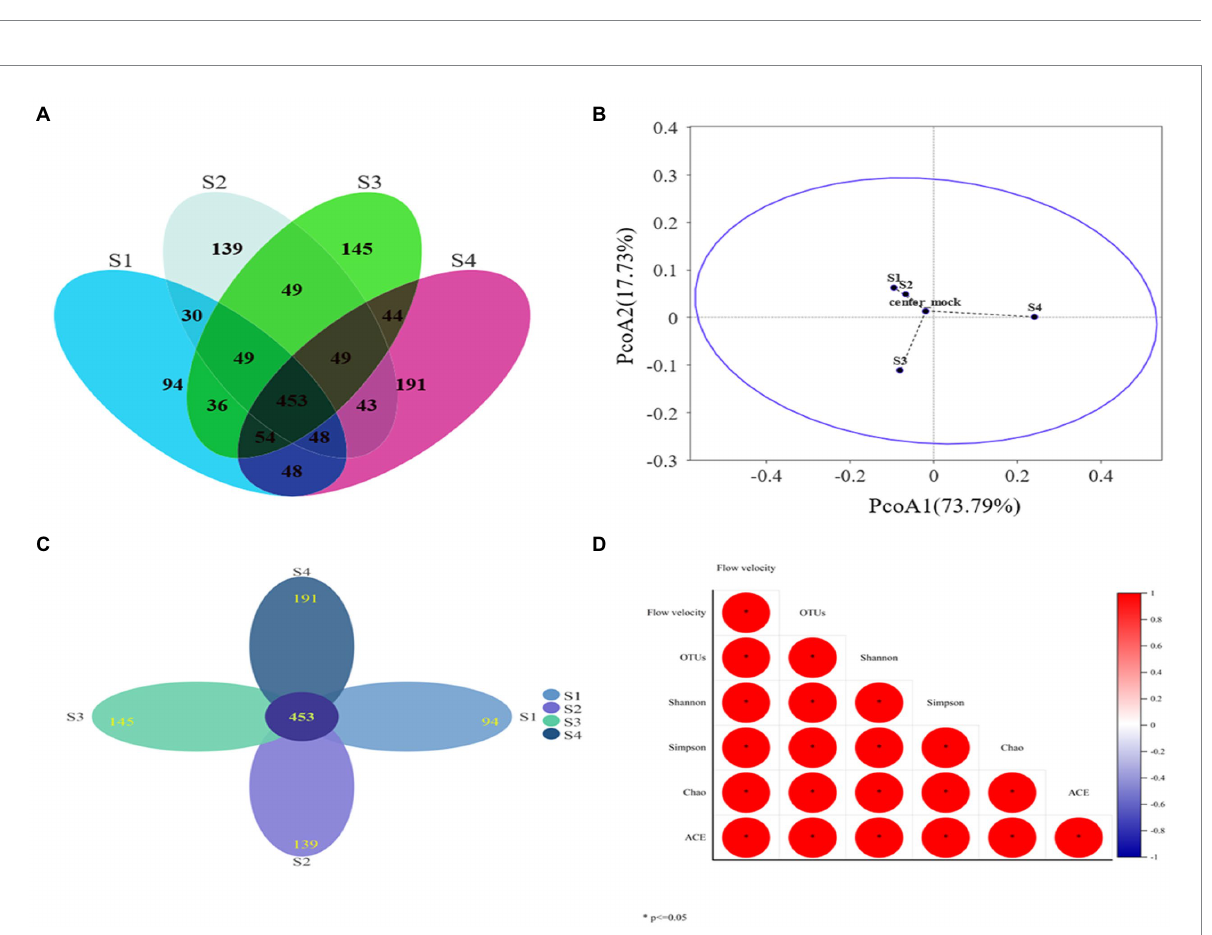
FIGURE 4 (A) Venn diagram of common and unique OTUs present in microbial communities under different water flow conditions; (B) PcoA analysis of OTUs (distance algorithm: Bray-Curtis); (C) Flower figure, each petal represents a sample, different colors represent different samples, the core number in the middle represents the number of OTUs common to all samples, and the number on the petal represents the number of OTUs unique to the sample. (D) Spearman correlation heat map of Alpha diversity index and flow velocity (* means significant correlation between the two indicators, p <